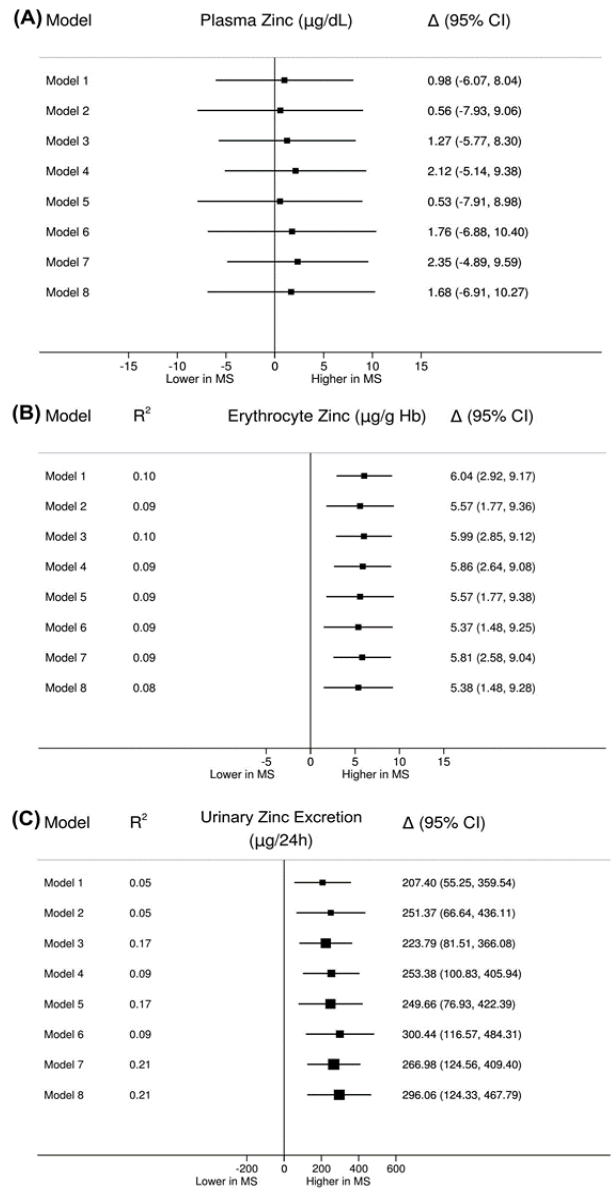
Figure 2. ( A ) Forest plot for comparison of plasma zinc concentration; ( B ) erythrocytes zinc concentration; and ( C ) 24 ‐ h urinary zinc excretion between patients with MS and the control group, according to the adjustment models. Model 1: without adjustment; Model 2: adjusted for zinc intake; Model 3: adjusted for sex; Model 4: adjusted for age; Model 5: Adjusted for zinc intake and sex; Model 6: Adjusted for zinc intake and age; Model 7: adjusted for sex and age; and Model 8: Adjusted for zinc intake, sex, and age. Horizontal lines indicate the 95% confidence interval (CI) for each model. When the confidence interval does not cross the vertical axis (centered at zero), the difference in the zinc biomarker concentration among the study groups is statistically significant ( p < 0.05). If the confidence interval line is to the right of the central axis, it indicates that the zinc biomarker concentration is higher for patients with MS compared to the control group. In contrast, if it is on the left of the central axis, it indicates that the concentration is lower in the MS group in relation to the controls. R2: determination coefficient; ∆ : estimates of the difference between patients with MS and controls, whose mean is inside the square ( ■ ); the area of each square is proportional to the variability explained by the model.